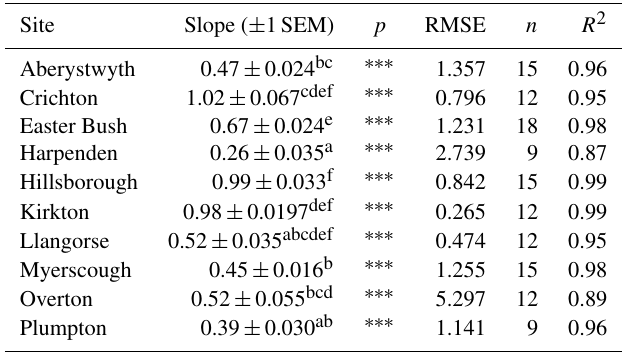
Table A4. Linear regression coefficients for the estimation of maximum fine-fraction organic carbon (gC per kg soil) with a forced zero intercept. Lettering indicates slopes that are significantly different ( p < 0 .